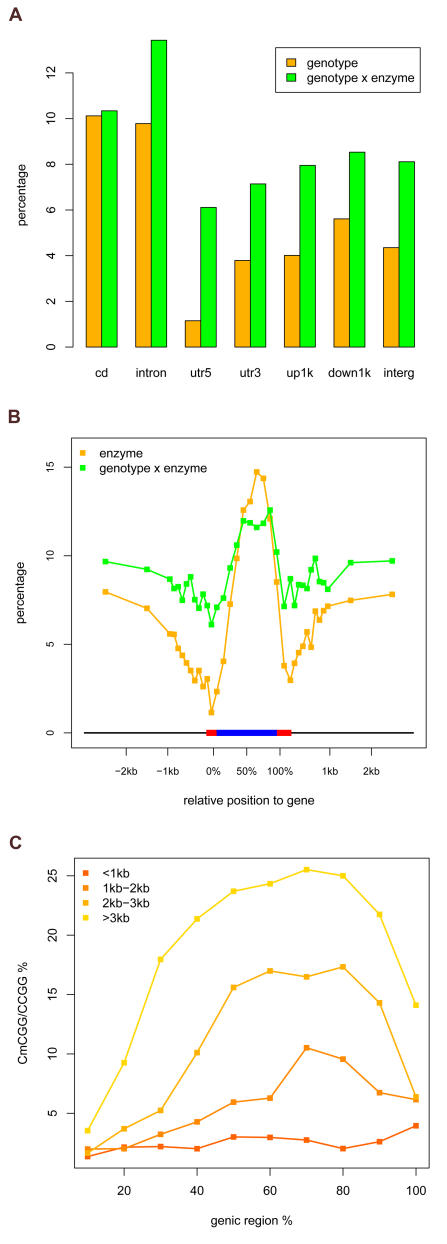
Genic Distribution of Constitutive and Polymorphic CG Methylation Sites.(A) Percent constitutive (orange) and polymorphic (green) CG methylation sites was calculated for seven annotation categories: coding sequence (CD); intron, 5′ UTR (utr5), 3′ UTR (utr3), sequence from transcriptional start to upstream 1 kb (up1k), sequence from transcriptional stop to downstream 1 kb (down1k), and inter-genic sequence (interg). (B) Percent constitutive (orange) and polymorphic (green) CG methylation sites was calculated along a typical gene. The results were based on all annotated genes possessing CCGG-containing feature(s) within the analyzed region. Gene sequences flanked by UTRs were divided to 10 percentiles based on position, upstream and downstream sequences were each divided to ten 100 bp intervals and two 1 kb intervals. Percent constitutive and polymorphic CG methylation sites was calculated for each interval and plotted as y-axis along a virtual gene of size 1900 bp (including 100 bp 5′UTR and 200 bp 3′UTR). Black lines: upstream and downstream sequences; red bar: UTRs; blue bar: gene sequences flanked by UTRs. The x-axis indicated the relative positions to the virtual gene. (C) Correlation between the size of gene (sequence flanked by UTRs) and the level of constitutive CG methylation. Genes possessing CCGG-containing feature(s) were separated to 4 groups based on their size. Within each group, gene regions were divided to 10 percentiles based on position, and the percent constitutive CG methylation (y-axis) was calculated for each percentile (x-axis).